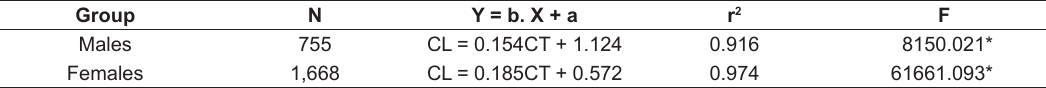
Table 2. Regression equation for relationship between total length (TL) and carapace length (CL) in both sex, in a population sampled in Miranda dam (MG), between April/2012 and May/2013. (N = number of